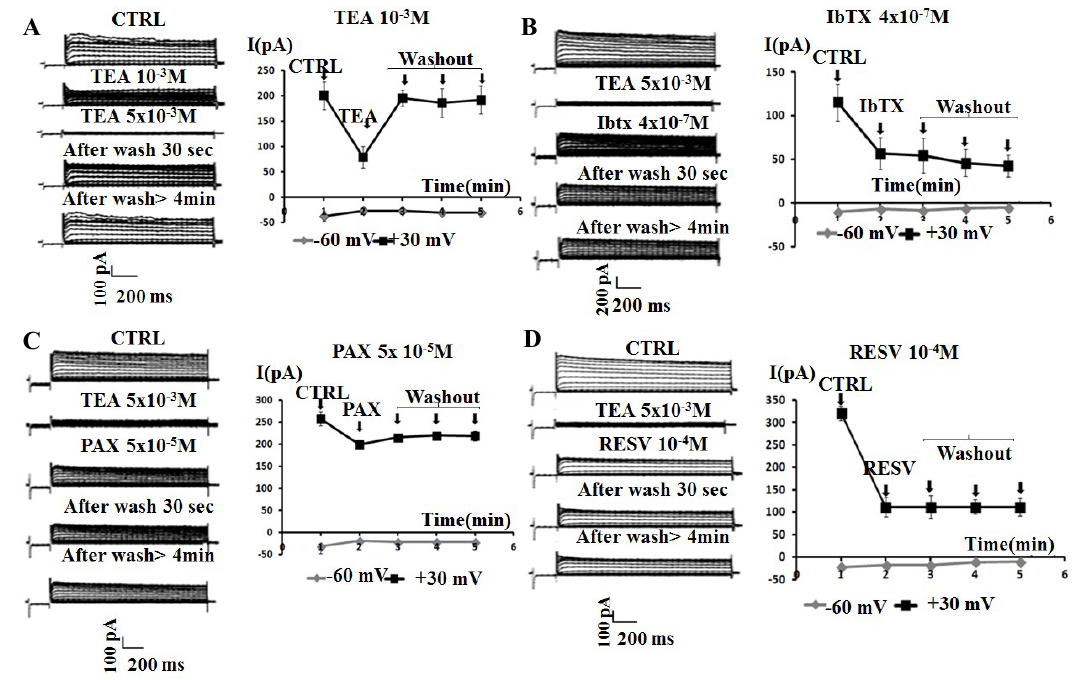
Figure 2. Sample traces of the whole-cell K + -current and time courses recorded in SH-SY5Y cells in the CTRL condition (CTRL) and following the addition of the Kv/BK channel blockers TEA, IbTX, PAX, and resveratrol (RESV) to the bath solution. The current was recorded in asymmetrical K + ions concentrations (int K + : 132 × 10 −3 M; ext K + : 2.8 × 10 −3 M) and in the presence of an internal concentration of free Ca 2+ ions of 1.6 × 10 −6 M. Membrane currents were activated by 500 ms voltage steps between −100 to +100 mV, starting from an HP of −60 mV (Vm). The leak current was recorded in the presence of a saturating concentration of TEA (5 × 10 −3 M). The four panels describe the effects of the application of the Kv/BK channel blockers under investigation on cells, according to the following scheme: current traces recorded in the control condition (CTRL); current traces recorded in the presence of TEA (5 × 10 −3 M); current traces recorded after the application of specific concentration of Kv/BK channel targeting compounds under investigation: ( A ) TEA 5 × 10 −3 M; ( B ) IbTX 4 × 10 −7 M; ( C ) PAX 5 × 10 −5 M; ( D ) RESV 10 −4 M); current traces recorded following two washout periods with the bath solution of 30 s and >4 min. Time courses of the K + current in the presence or absence of the compounds under investigation recorded at physiological Vm of +30 and −60 mV. Each point is the mean + SEM of 3 cells. The incubation of the cells with TEA induced almost a total reduction of the current, which was fully reversible within 30 s of washout with bath solution. In contrast, the incubation of cells with IbTX, RESV, and PAX induced a partial reduction of the total K + current, which was not reversible within 4 min of washout with bath solution.